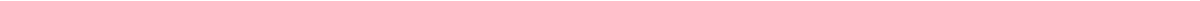
Fig. 3 Cardiac miR-128 deletion promotes postnatal CM proliferation in vivo. a Schematic diagram depicting the generation of cardiac-speci fi c miR-128 knockout ( miR -128 − / − ) mice. Control mice were miR-128 fl / fl mice, and miR-128 − / − mice were Nkx2.5 Cre ; miR-128 fl / fl mice. b The expression level of miR-128 during heart development ( n = 6) analyzed by qPCR, including embryonic day 10.5 (E10.5), E14.5, postnatal day 7 (P7), and P28. c Masson trichrome staining of mouse hearts at P7. Scale bars, 2.0 mm. d Comparison of cardiac function between Ctrl and miR-128 − / − hearts analyzed by echocardiography at P7, and measured by EF and FS ( n = 6). e Measurement of HW to BW ratio in Ctrl and miR-128 − / − mice ( n = 6). f Evaluation of CM size in P7 Ctrl and miR- 128 − / − hearts assessed by WGA and cardiac troponin T (cTnT) staining ( n = 5 mice, ~250 CMs/heart). Scale bars, 50 µ m (yellow); 10 µ m (white). g Assessment of CM proliferative activity and sarcomere structure in P7 hearts by immuno fl uorescence of cTnT and Ki67. Arrows indicate Ki67-positive CMs with sarcomere disassembly. Scale bars, 500 µ m (yellow); 25 µ m (white). h – j Quanti fi cation of Ki67 + CMs, sarcomere disassembled CMs and Ki67 + disassembled CMs ( n = 4860 CMs pooled from six mice). k CM apoptosis analyzed by TUNEL staining. l Schematic diagram depicting the protocol for EdU intraperitoneal (i.p.) injection at P7 mice to label proliferating CMs in vivo. m Analysis of CM proliferation by EdU incorporation assay in Ctrl and miR-128 − / − hearts at P14 ( n = 6 mice, ~250 CMs/heart). Scale bars, 50 µ m. n Schematic diagram depicting the protocol for EdU intraperitoneal (i.p.) injection at P14 to label proliferating CMs in vivo. o Comparison of EdU + CMs in Ctrl and miR-128 − / − hearts at P21 ( n = 6 mice, ~200 CMs/heart). Statistical signi fi cance was calculated using Student ’ s t -test. Data are represented as means ± SEM. * P <